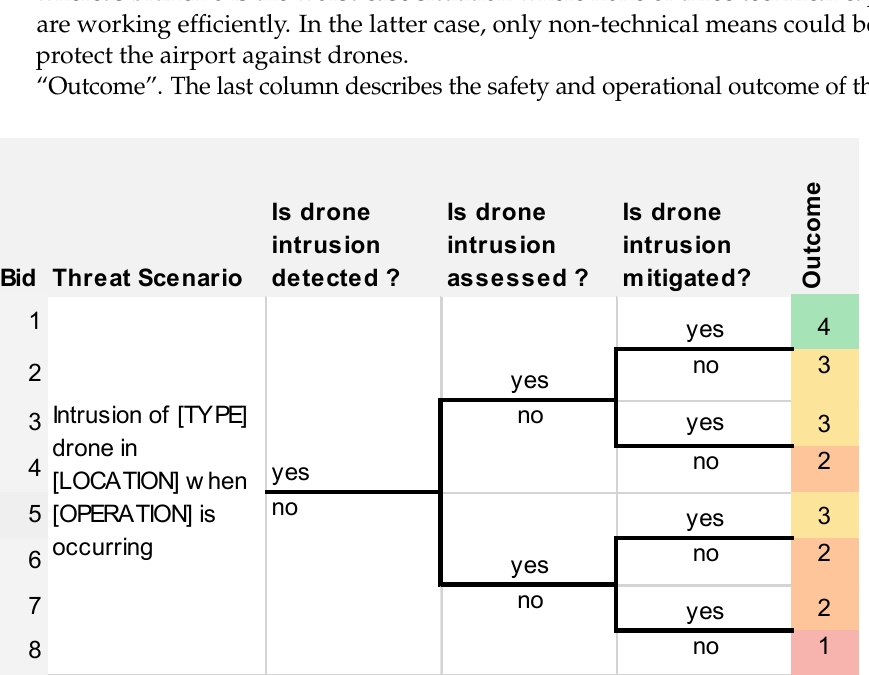
Figure 3. Qualitative view of the even tree for the assessment of threat scenarios related to drone intrusions in airports.